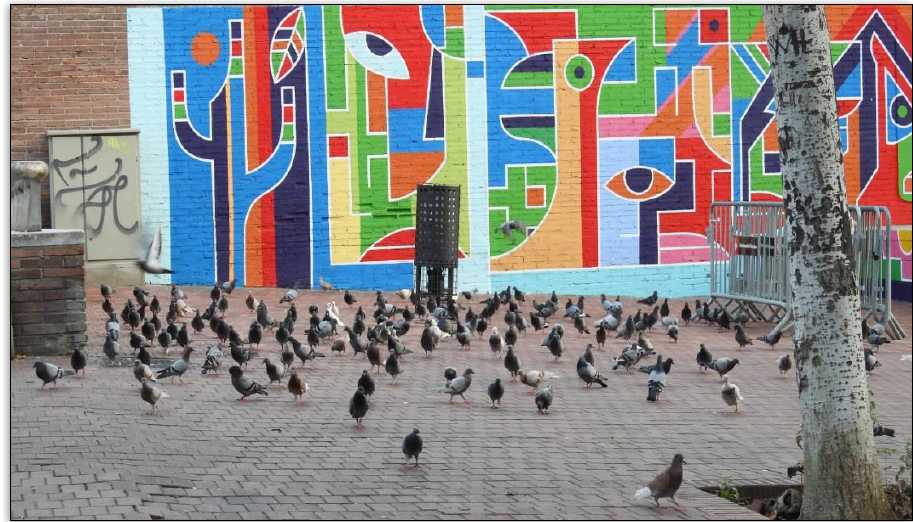
Figure 9. Pigeons waiting around an AHF for the administration of the